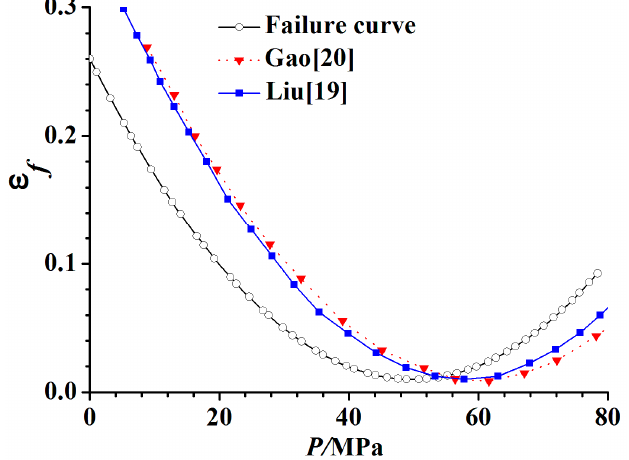
Figure 3. Comparison of J 2 − p relationship between theoretical results and single element test results.